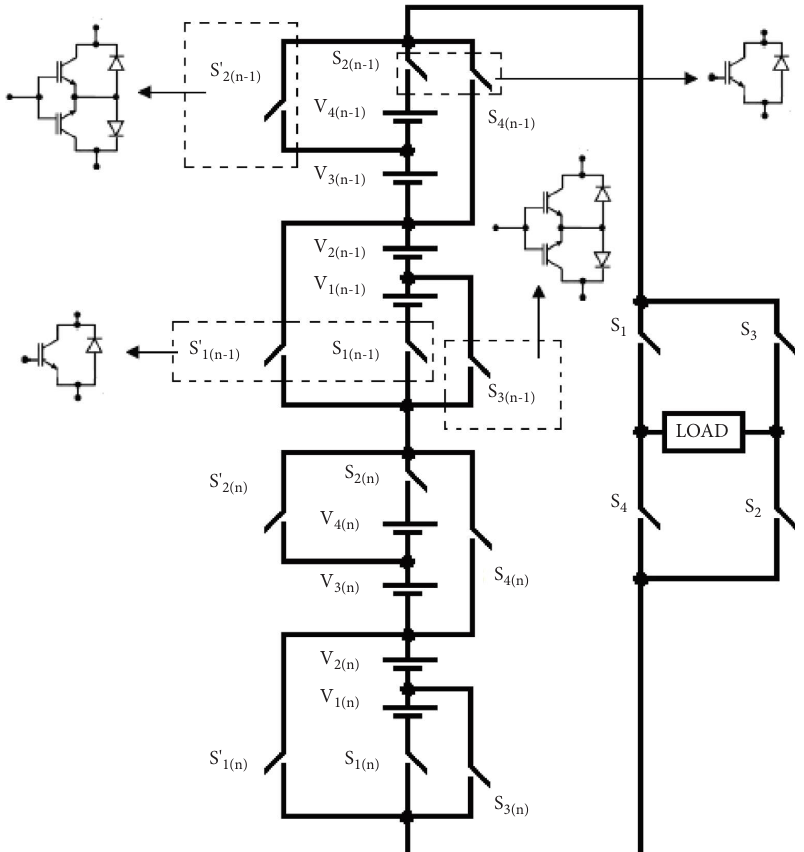
Figure 3: Proposed single-phase